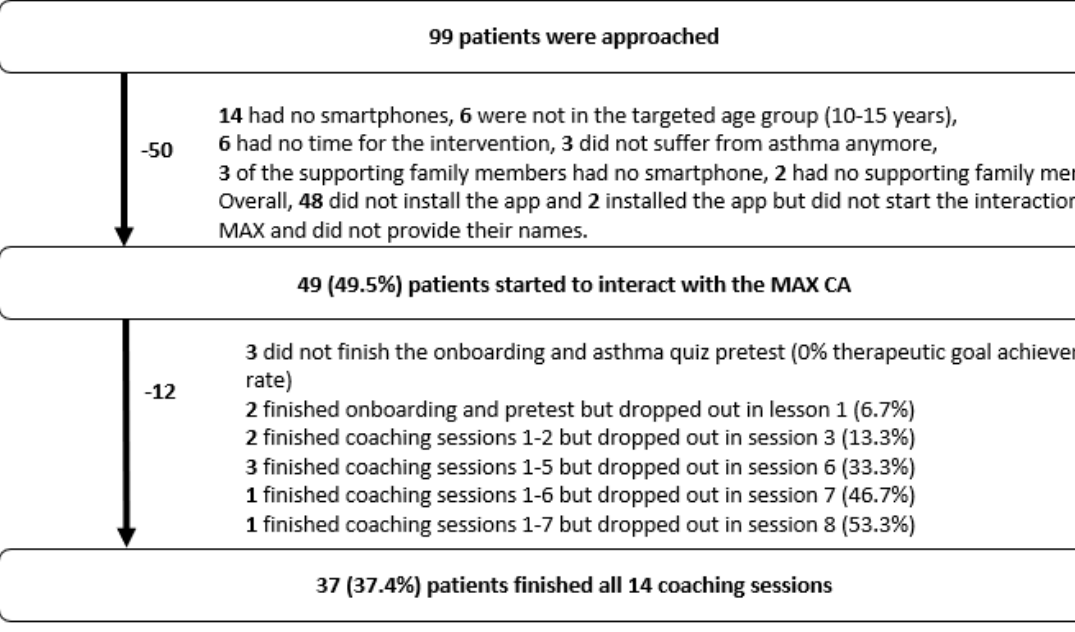
Figure 4. Subject acquisition and participation flow chart. CA: conversational